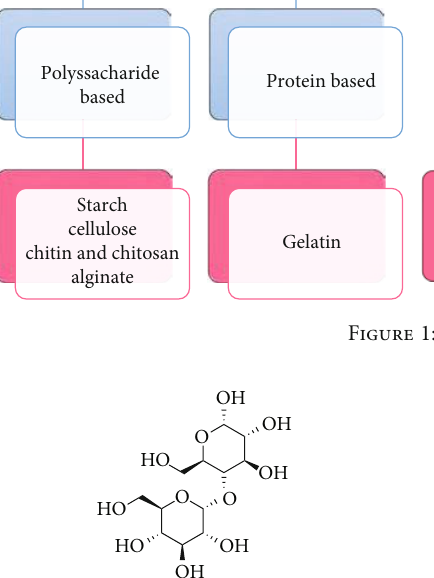
Figure 2: Chemical structure of